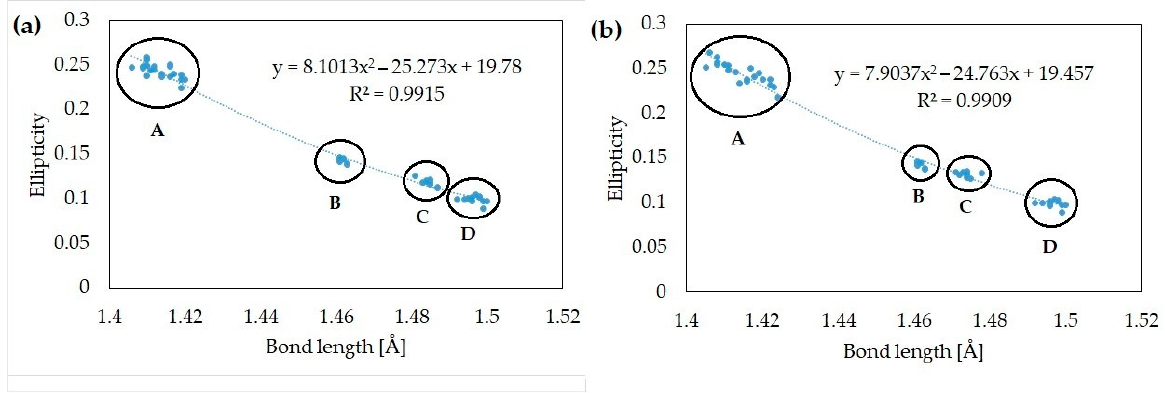
Figure 2. Correlations between ellipticity and bond length for ( a )—C8a-C9 bond, ( b )—C9a-C9 bond. Region A—enol, B—ketone form with two hydrogen bonds, C—ketone form with one hydrogen bond, D—ketone form without hydrogen bonds.